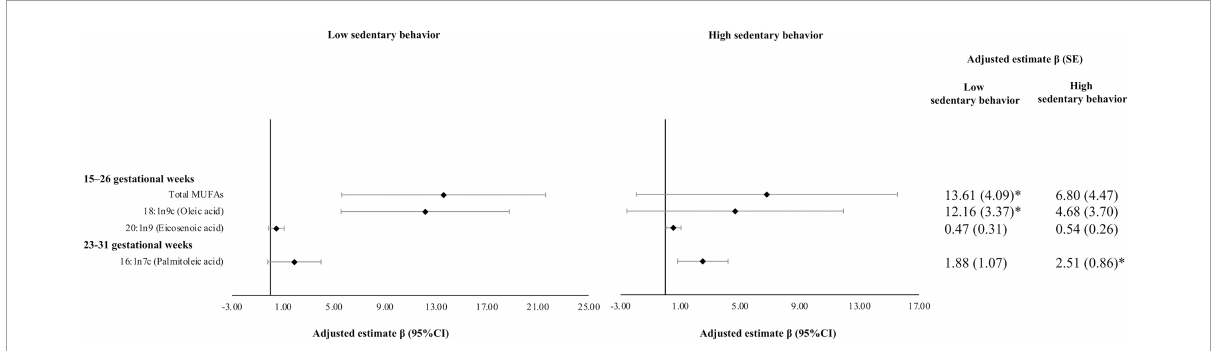
FIGURE1 Associations of moderate-to-vigorous physical activity (MVPA) with plasma monounsaturated fatty acids (MUFAs) by sedentary behavior. Multivariable models adjusted for age (years), race, education, marriage status, nulliparous, pre-pregnancy BMI (kg/m 2 ), and AHEI score. AHEI score used mean imputation for missing values. Sampling weights were applied to all analyses to represent the full NICHD Fetal Growth Studies–Singletons population. Units of continuous MVPA used hours per week. β ∗ 10 2 (SE ∗ 10 2 ) were reported. Women were classified into high sedentary behavior group if they had ≥ 42 h of sedentary behavior per week. ∗ P -value is significant after Bonferroni correction. PA since the prior visit was measured at the two visits. Individual MUFAs were expressed as % of total fatty acids. AHEI, Alternative Health Eating Index; BMI, body mass index; MUFAs, monounsaturated fatty acids; MVPA, moderate-to-vigorous physical activity; NICHD, National Institute of Child Health and Human Development; PA, physical activity; SE, standard